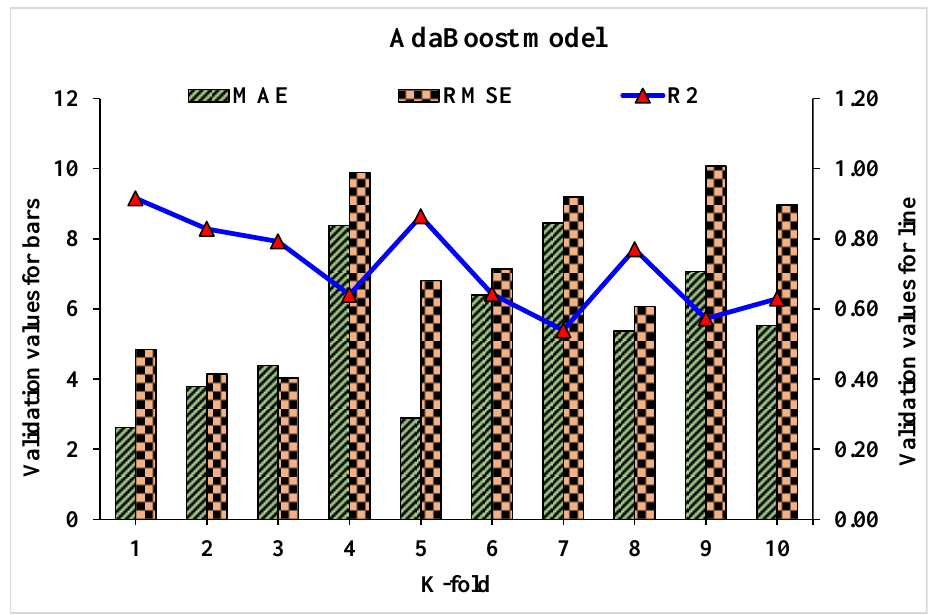
Figure 20. Statistical analysis of AdaBoost model for K-fold cross-validation.